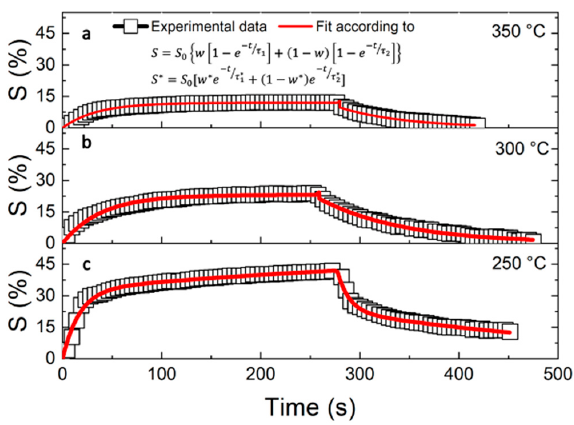
Figure 2. Dynamic resistance variations of the WO 3 -based sensor (black curve) at 350 ◦ C under cycles of different NO concentrations (red curve). The arrows indicate when NO was fluxed into the chamber (named “gas in”) or it was stopped (named “gas out”), which coincided with the start of the response and the recovery phases, respectively.